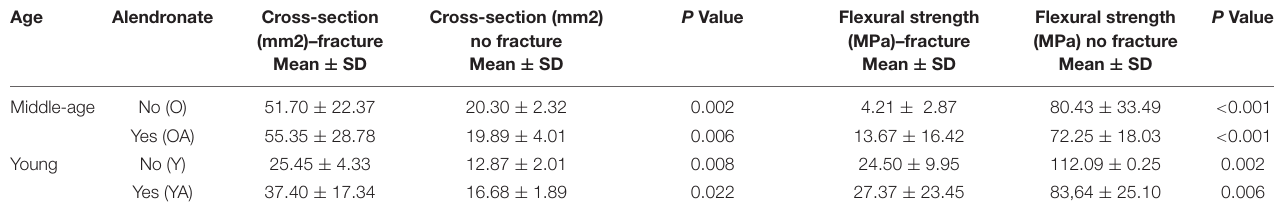
TABLE 4 | Comparison of cross-section and flexural strength in animals with and without alendronate treatment between the femurs on the fractured and non-fractured side.